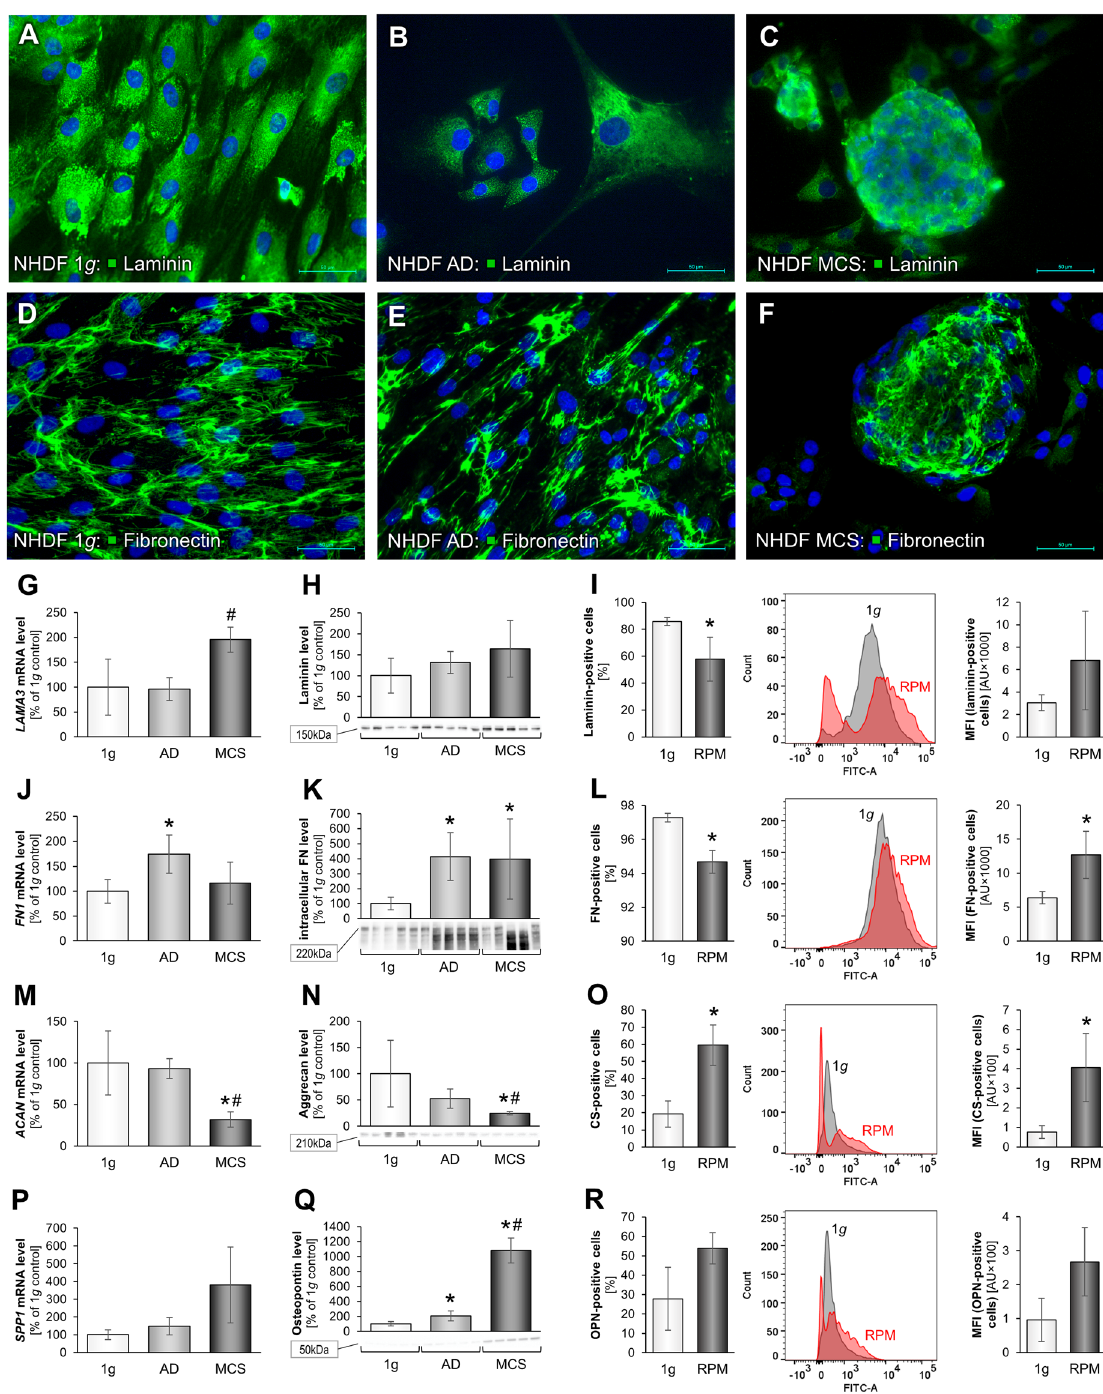
Figure 2. Changes in the ECM composition of NHDF after a three-day RPM-exposure: Immunofluorescence images of 1 g -control cells, RPM-AD and RPM-MCS of laminin ( A – C ) and fibronectin ( D – F ). Transcriptional and translational laminin analysis: Quantitative gene expression levels of LAMA3 ( G ), intracellular laminin levels ( H ) and flow cytometric analysis of laminin-labeled cells ( I ) displaying the percentage of laminin- positive cells as well as alteration of the median fluorescence intensity (MFI). Transcriptional and translational fibronectin analysis: Quantitative gene expression levels of FN1 ( J ), intracellular fibronectin levels ( K ) and flow cytometric analysis of fibronectin-labeled cells ( L ). Transcriptional and translational aggrecan analysis: Quantitative gene expression level of ACAN ( M ), intracellular aggrecan levels ( N ) and flow cytometric analysis of chondroitin sulfate-labeled cells ( O ). Transcriptional and translational osteopontin analysis: Quantitative gene expression levels of SPP1 ( P ), intracellular osteopontin levels ( Q ) and flow cytometric analysis of osteopontin-labeled cells ( R ). Full-length blots of cropped Western blot images are presented in Supplementary Fig. S1. * p < 0.05 1 g vs. RPM; # p < 0.05 AD vs. MCS. Scale bars: 50 µ